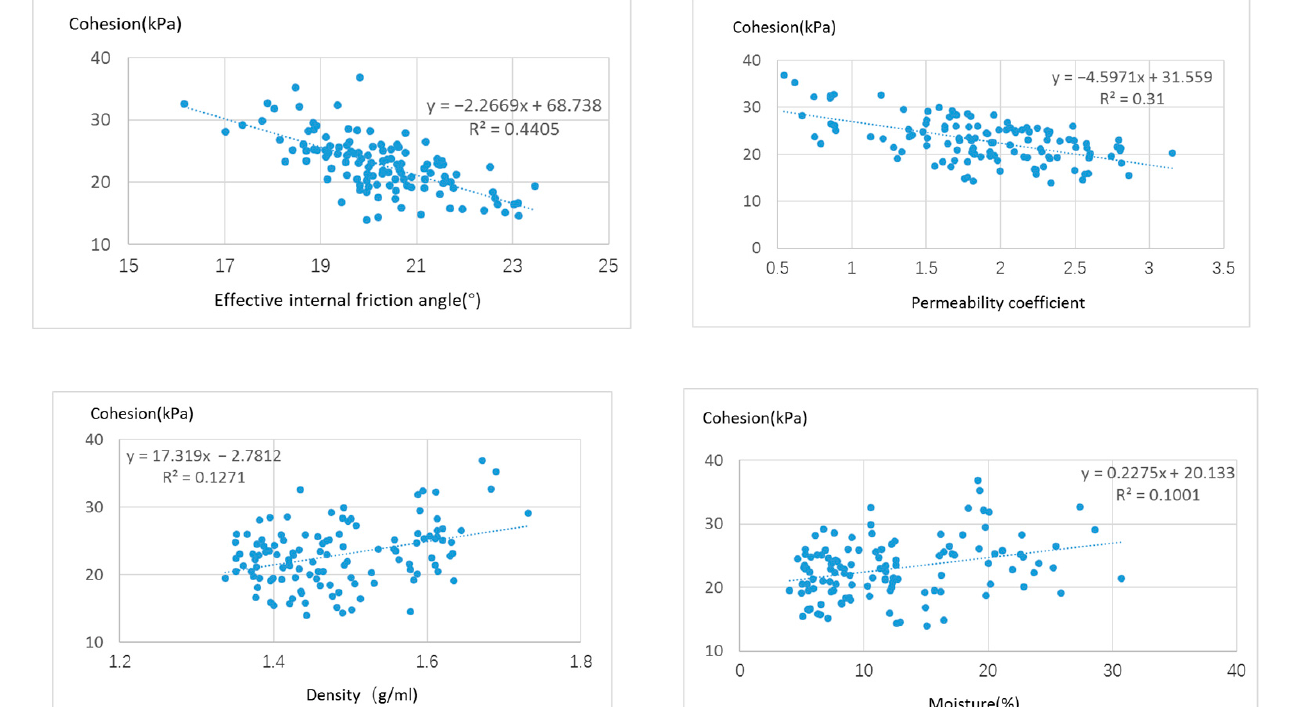
Figure 4. Scatter plot of cohesion and its influencing factors.